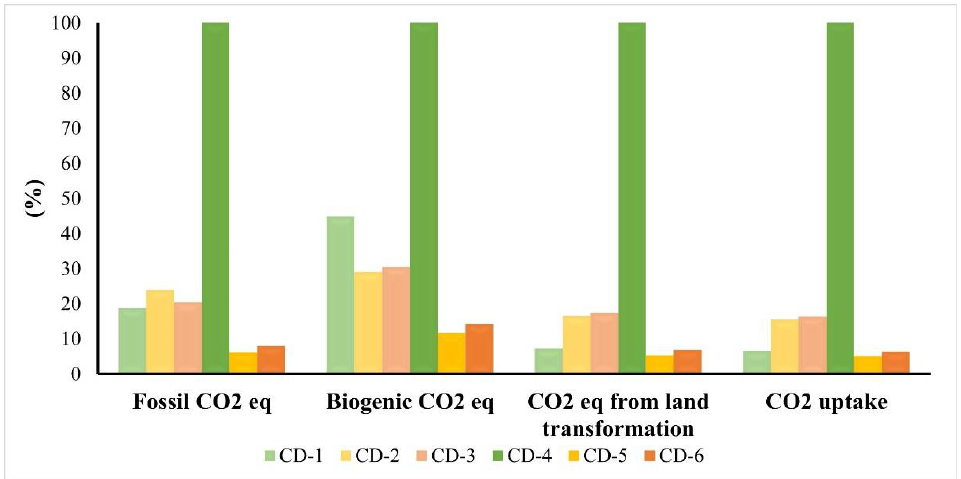
Figure 7. Relative environmental impacts of syntheses under study for landfill disposal scenario, applying Greenhouse Gas Protocol method. Green scale refers to hydrothermal treatments; Yellow scale refers to microwave-assisted treatments; Orange scale refers to calcination treatments.